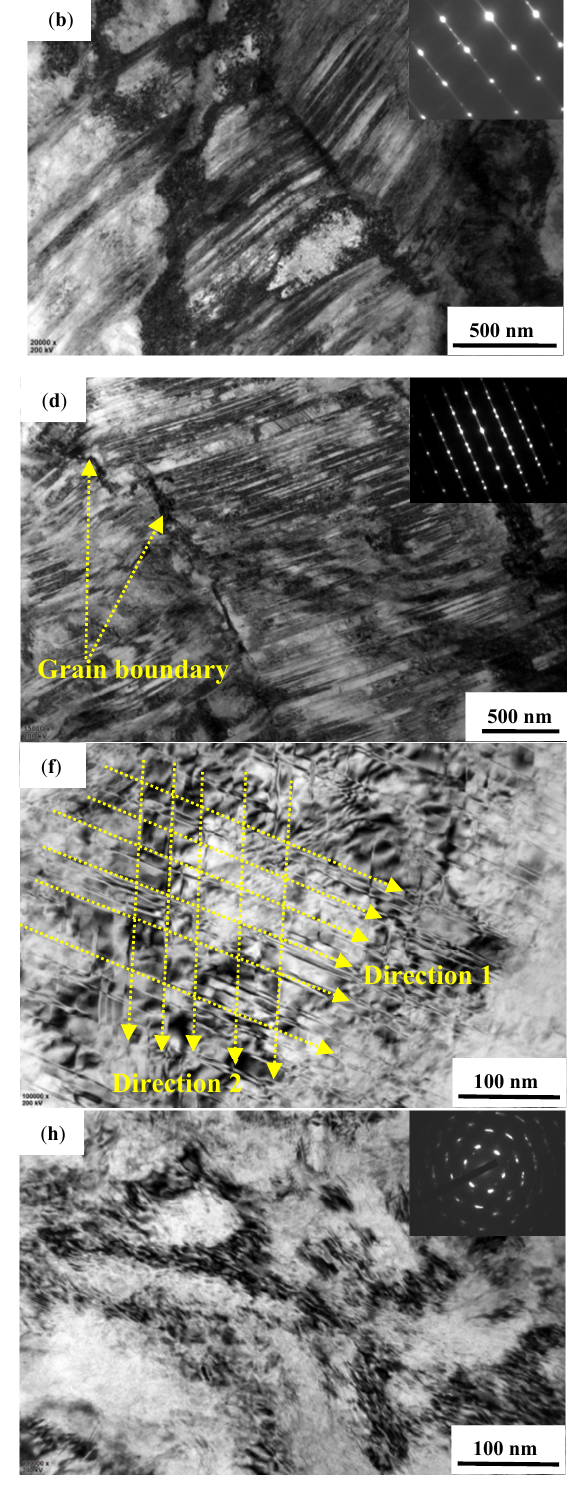
Figure 4. TEM images of Fe-25Mn-3Si-3Al-0.3Nb steel after cold rolling: ( a , b ) after 30% deformation; ( c , d ) after 50% deformation; ( e – h ) after 70% deformation.